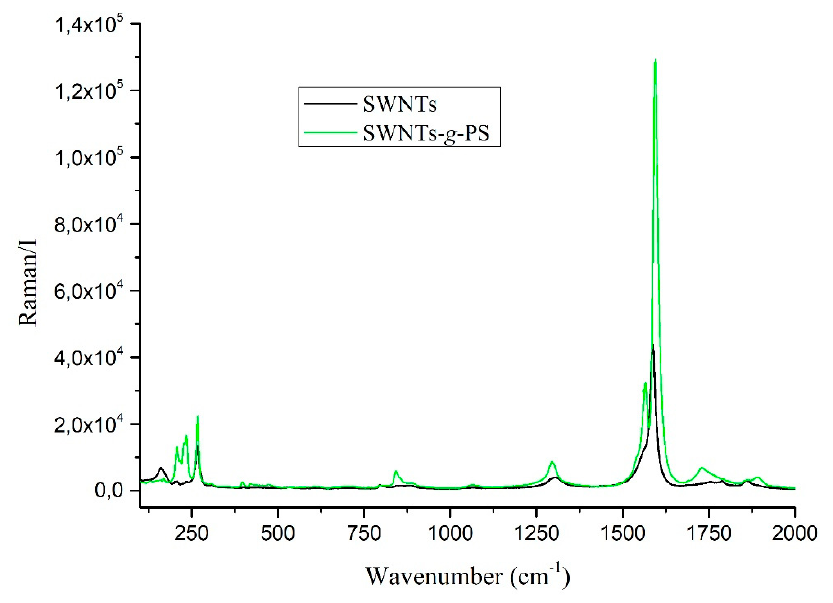
Figure 6. Raman spectra of pristine SWNTs, and SWNTs- g -PS 4.5K.